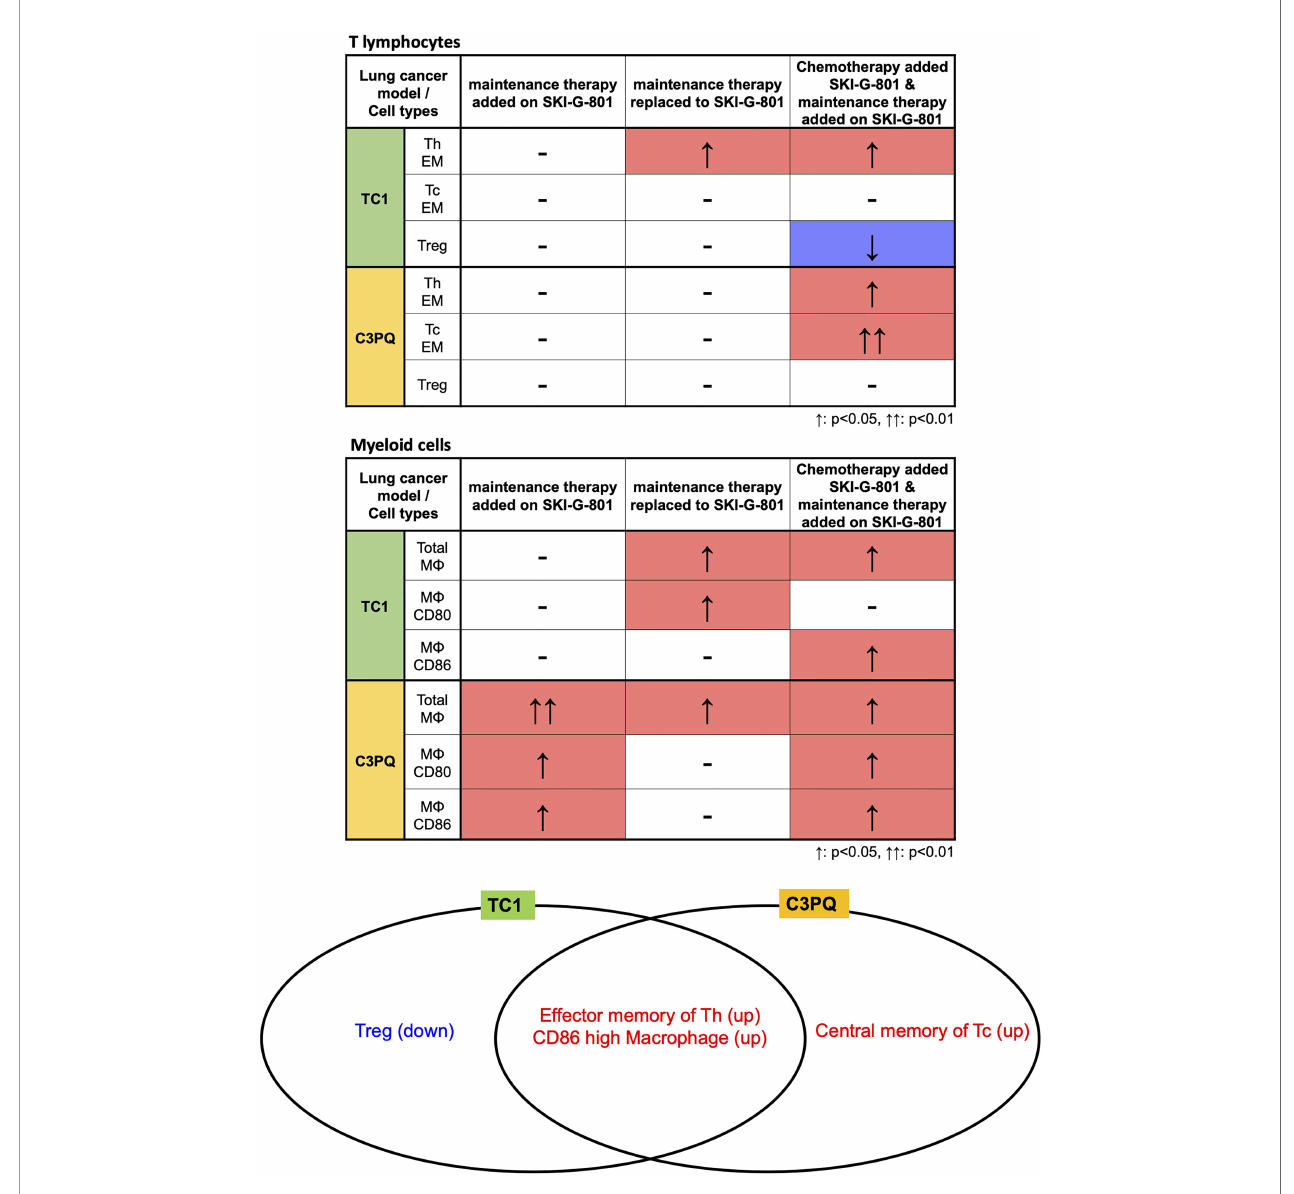
FIGURE 6 | Immunological bene fi ts of SKI-G-801 addition to chemotherapies in TC1 and C3PQ tumor models. The differences in immune cell changes between TC1 and C3PQ after treatment in each group is shown. The number of effector memory Th cells and CD86 + high macrophages was similar in TC1 and C3PQ. In particular, Tregs were downregulated in TC1, and central memory of Tc cells were upregulated in C3PQ. ↑ : p < 0.05, ↑↑ : p <